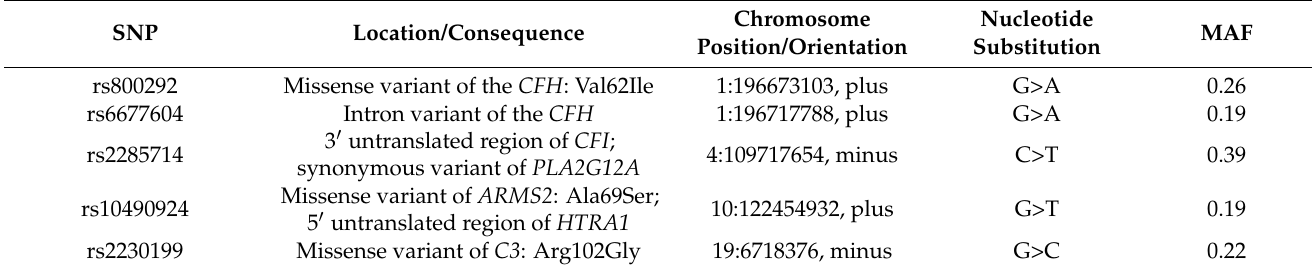
Table 1. SNPs analyzed in the